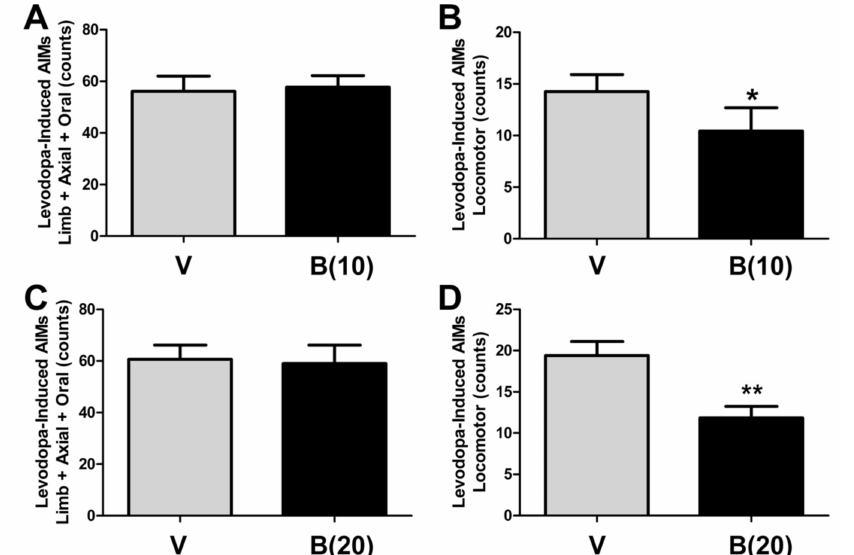
Figure 3. At the dose of 10 mg/kg ( i.p. ) BBI-11008 had no effect on limb, axial and oral (LAO) abnormal involuntary movements (AIMs), but significantly reduced locomotor AIMs. At this dose, BBI-11008 had also been shown to be effective in rodent models of pain. ( A ) The mean total LAO AIMs scores over 180 min are plotted and there was no difference between vehicle (gray bar) and drug (black bar) condition (mean AIMs count ± SEM; n = 10; paired Wilcoxon signed-rank test). (B) The mean total locomotor AIMs scores over 180 min were plotted and there was a significant 30% reduction from vehicle (gray bar) in the drug (black bar) condition (mean AIMs count ± SEM, * p < 0.05, n = 10, paired Wilcoxon signed-rank test). At the dose of 20 mg/kg ( i.p. ) BBI-11008 had no effect on LAO AIMs, but reduced locomotor AIMs. ( C ) The mean total LAO AIMs scores over 180 min were plotted and there was no difference between vehicle (gray bar) and drug (black bar) condition (mean AIMs count ± SEM, n = 10, paired Wilcoxon signed-rank test). ( D ) The mean total locomotor AIMs scores over 180 min were plotted and there was a significant 50% reduction from vehicle (gray bar) in the drug (black bar) condition (mean AIMs count ± SEM, ** p < 0.01, n = 10, paired Wilcoxon signed-rank